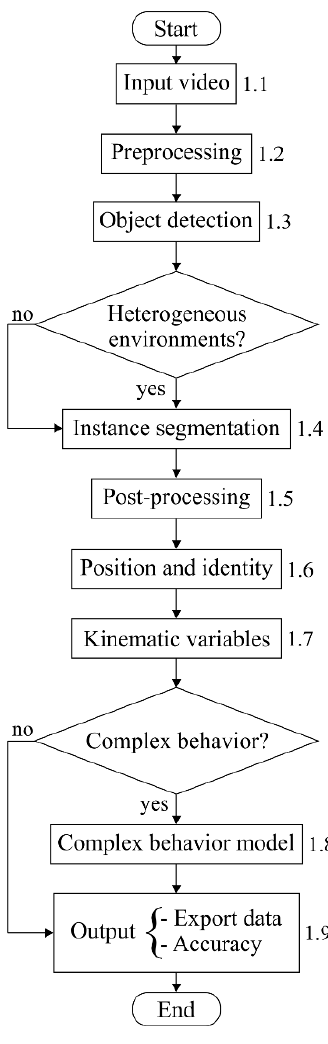
Figure 1. Flowchart of the Ethoflow algorithm. The numbers on the right side of the rectangles indicate the steps in the algorithm process. These steps are described in the subsequent sections from Sections 3.1.1–3.1.9. Diamond symbols indicate the option of using the deep learning algorithms (for